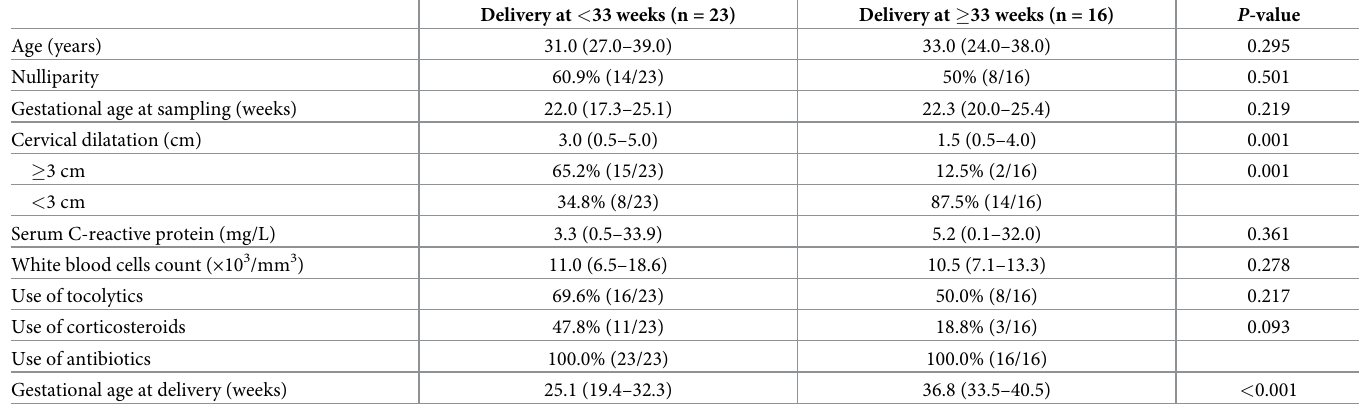
MET, and LXN, respectively) were � 3 cm, � 0.098, � 0.072, � 0.035, � 0.199, � 0.040, and � 0.512, respectively (Table 1). High PARs for LEGEACGVYTPR, DVLTFTCEPK, and IIYGPAYSGR and a low PAR for FAVEEIIQK were significantly associated with SPTD at < 33 weeks of gestation after cerclage, after adjustment for advanced cervical dilatation ( � 3 cm, Table 3). However, three candidate biomarker peptides, LIQGAPTIR, TDCPGDALFDLLR, and GDLTIANLGTSEGR were not found to be associated with SPTD at < 33 weeks, after adjustment for advanced cervical dilatation (Table 3).